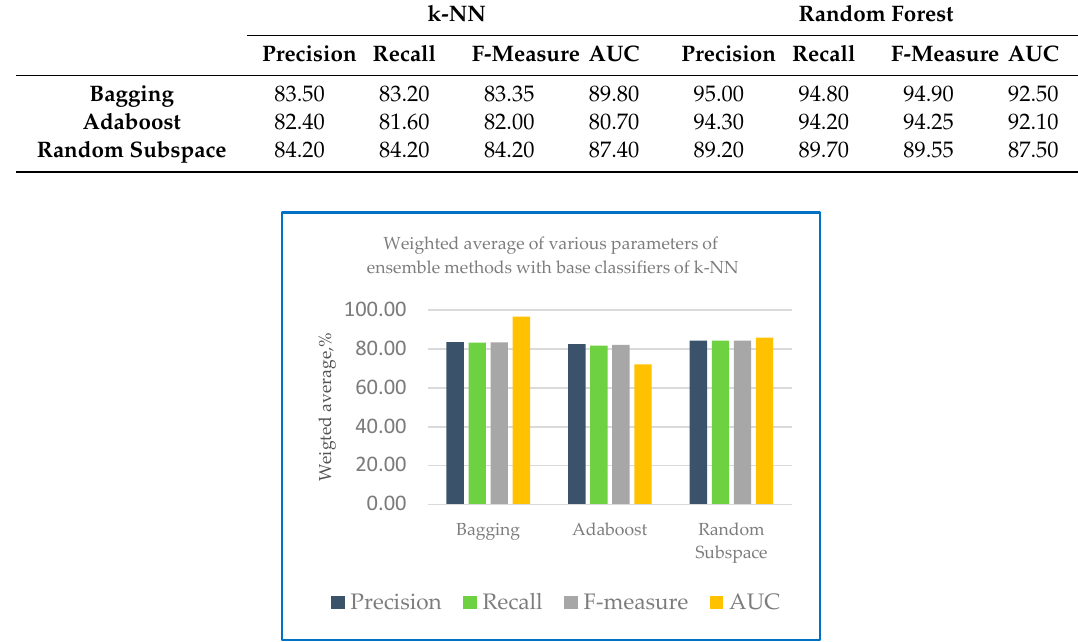
Table 8. Performance measures with base classifiers of k-NN and RF on 10-fold cross validation method.